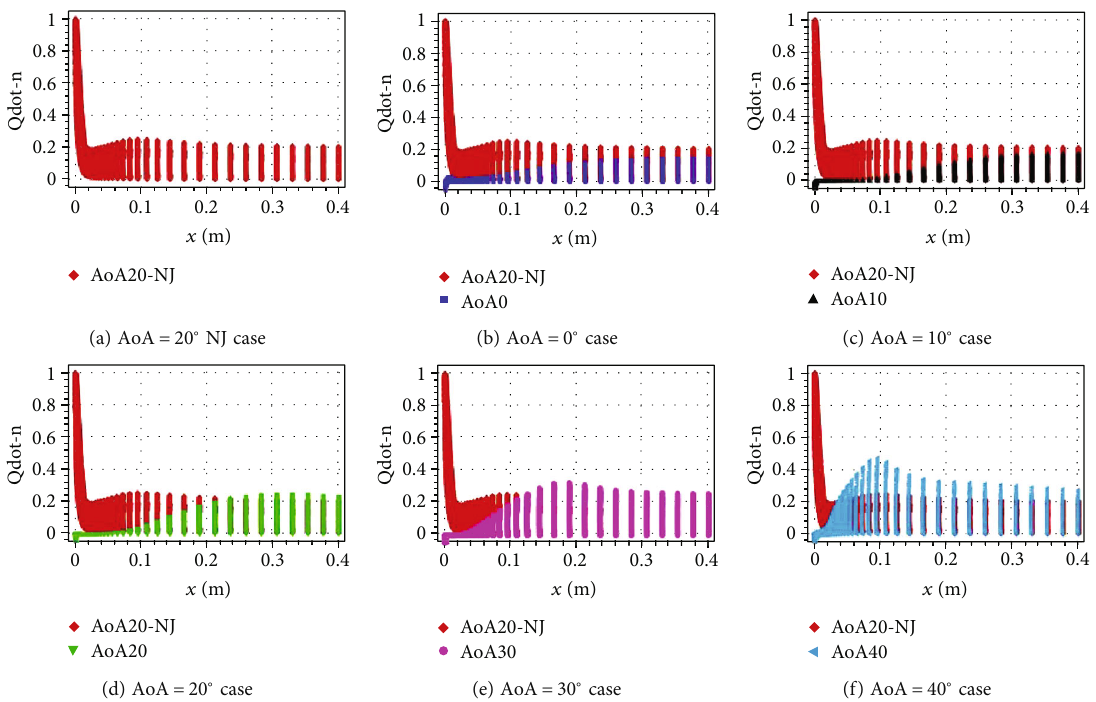
Figure 20: _ QN values of the NJ and J cases for di ff erent AoAs of the H40Ma5